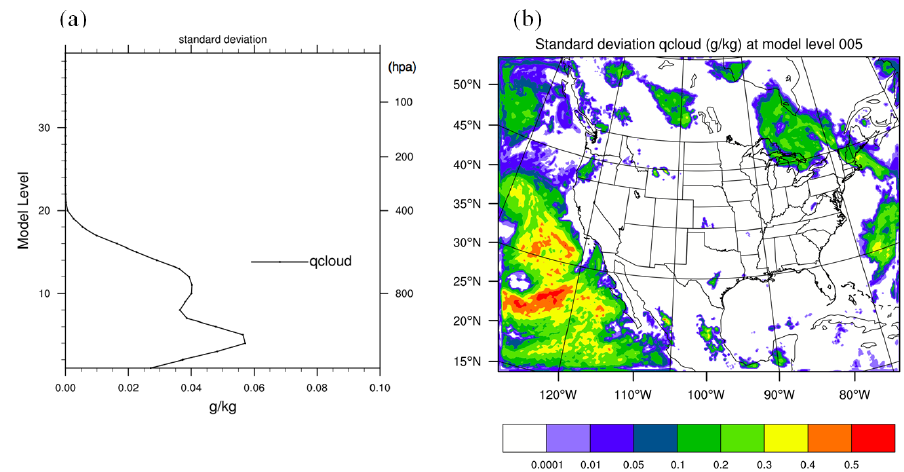
Figure 18. (a) Profile of standard deviation of the liquid water condensate mixing ratio ( q cloud in gkg − 1 ) averaged along the vertical and (b) horizontal cross sections of the standard deviation of q cloud at vertical model level 5 (950hPa). Both plots indicate the presence of low maritime clouds noted by high standard deviation (WRF, res. 15km,